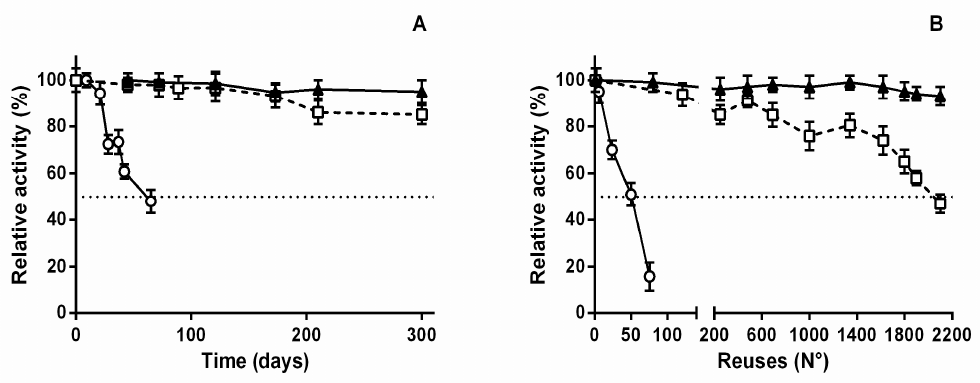
Figure 7. Storage stability at 4 °C ( A ) and reusability ( B ) of ( ▲ ) SiG PEI25000 - Ld NDT-Alg, ( □ ) SiG PEI25000 - Ld NDT, and ( ○ ) CNBr- Ld NDT.